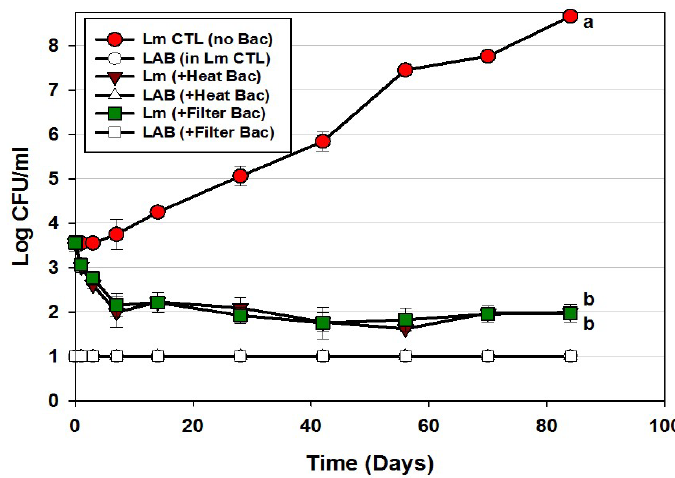
Figure 5. Hotdog challenge study with surface-applied bacteriocin extracts comprising 3 MOAs (curvaticin FS47 and Beef3, pediocin Bac3, and lacticin FLS1; Trial #4). L. monocytogenes 39-2 was either inoculated on hotdogs alone, or with added heat-treated or filter-sterilized CFS preparations, vacuum-packaged, and held for up to 12 weeks at 5 °C. Platings for LAB from these 3 treatments were also made on acidified MRS (hollow symbols). All sample treatments were performed in triplicate; data points represent the means and error bars represent the standard deviation from the means. Treatments with different letters are significantly different (repeated measures, p < 0.05); those sharing the same letter are not significantly different, p > 0.05).